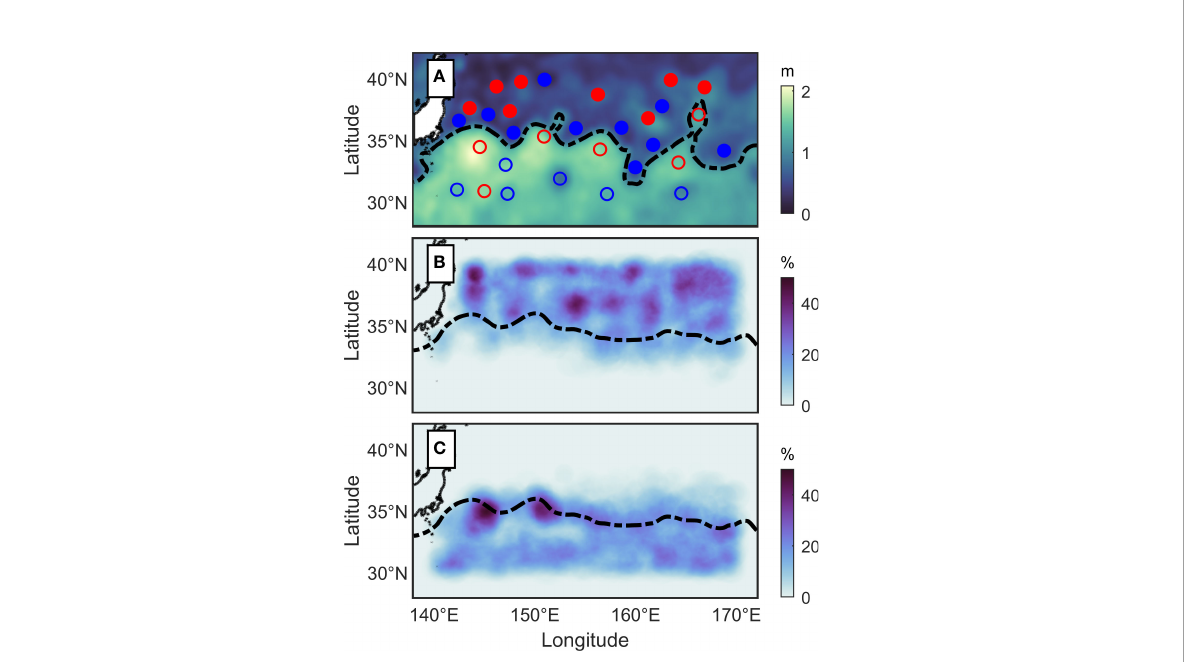
FIGURE 3 (A) Example of delineating the north and south sides of the KE with daily sea surface height (SSH) on September 26, 2004, and the corresponding eddies on each side. The black dotted line is the 170 cm SSH contour, representing the main path of the KE. Red (blue) circles represent the centers of the anticyclone (cyclone), and solid (hollow) circles represent eddies in the north (south). (B, C) represent the percentages of eddy occurrence to the north and south of the KE main path, overlaid with the averaged main path of KE (dashed